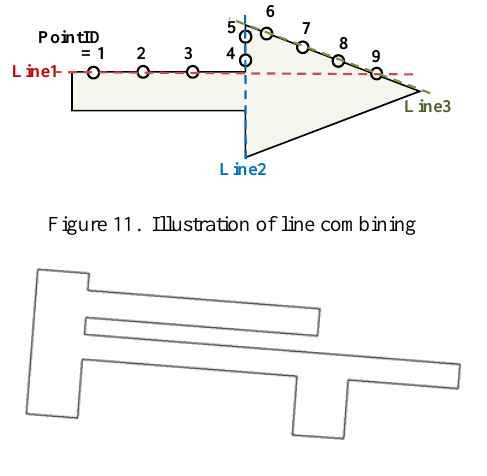
Figure 12. Extracted traffic marking